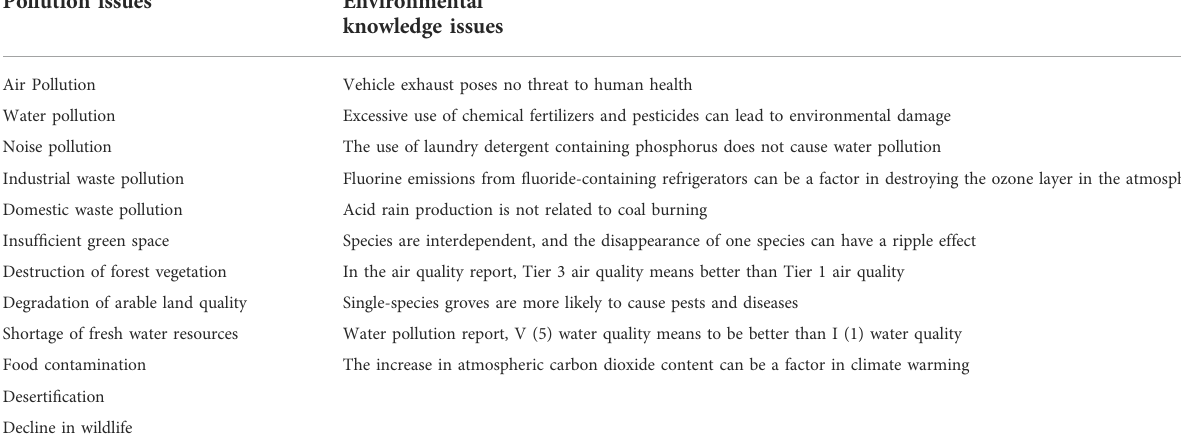
TABLE 10 Questions about environmental perception and